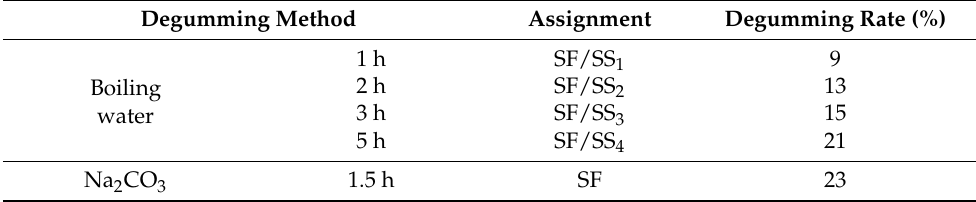
Table 1. Degumming method and degumming rate of